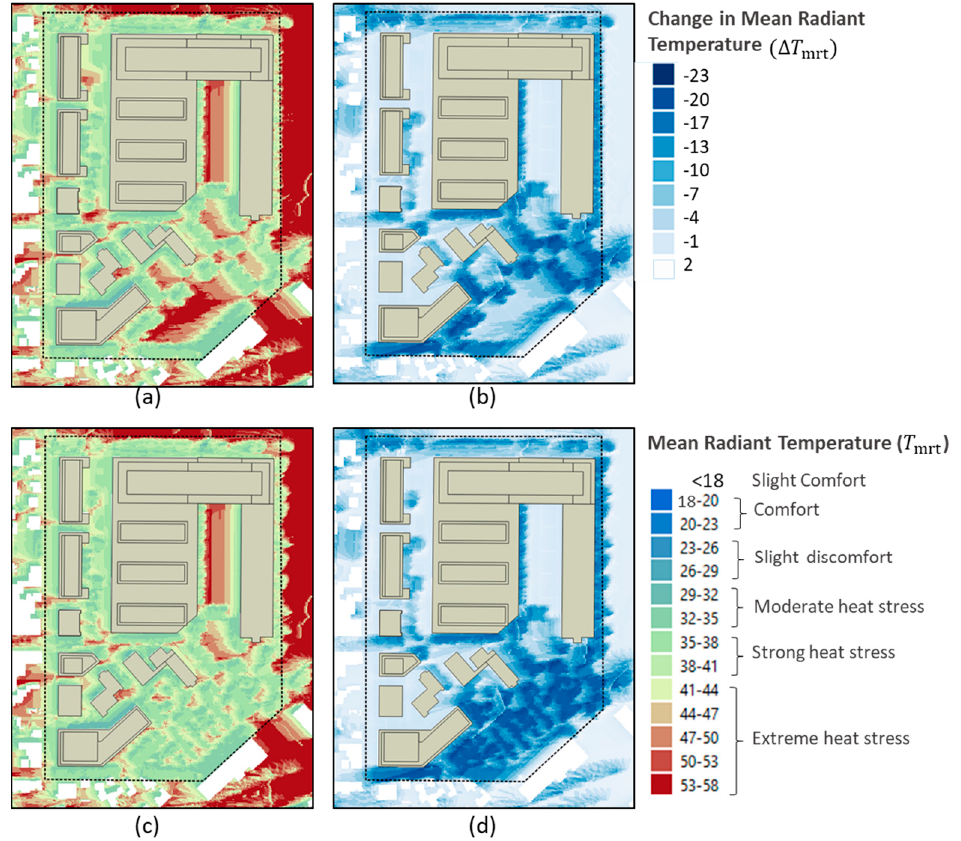
Figure 14. Average T mrt for the hottest period of days (12:00–19:00) following the strategic addition of trees in level 1 ( a ) and level 2 ( b ); the change ( Δ ) in T mrt with the baseline map (the condition without tree placement) in level 1 ( b ) and level 2 ( d ).